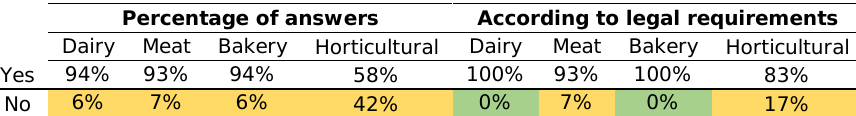
Table 2. Audited companies with organized occupational health and safety